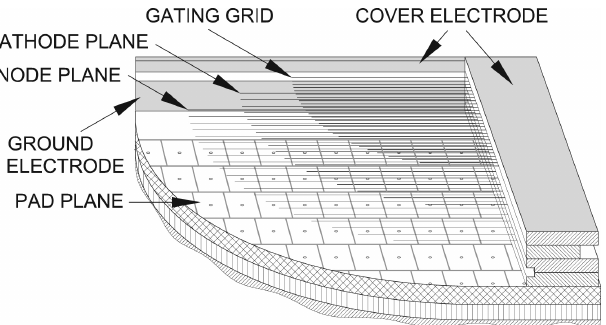
Figure 44. Schematic diagram of the ALICE MWPC-based ROC with pad plane readout, from Ref. [96].